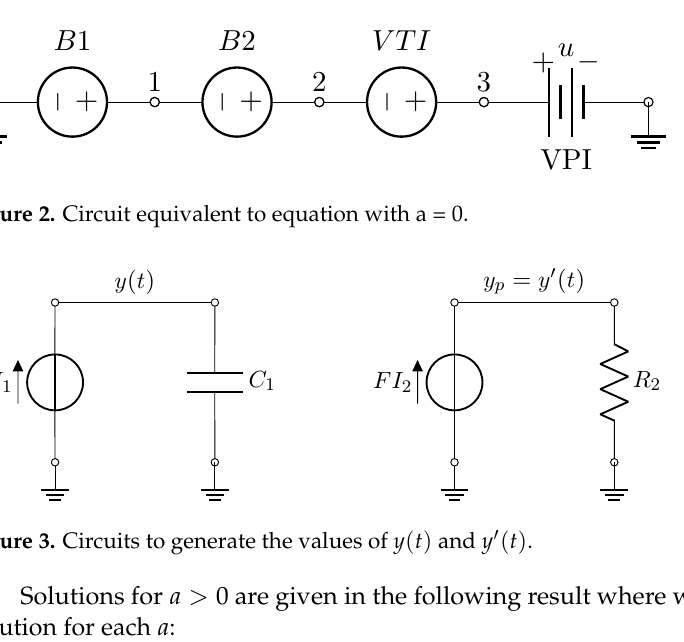
Figure 1. NSM and Matlab solution for t < 1.